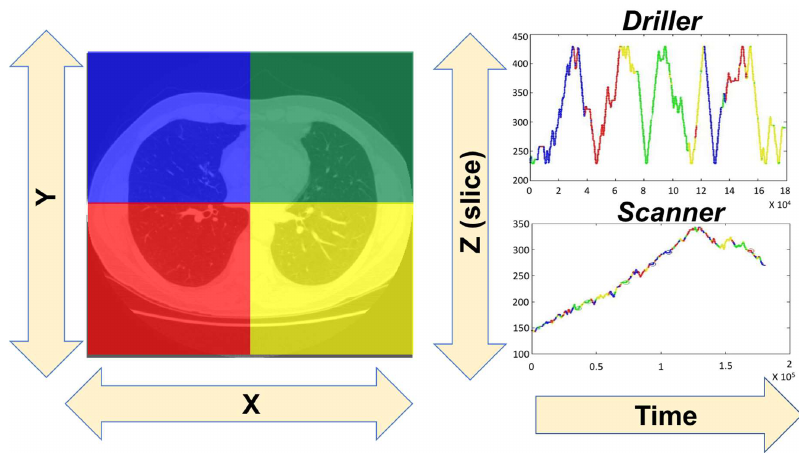
Figure 2. To visualize an approximation of the 3D scanpath through the lungs, position in the XY plane is coarsely color-coded into four quadrants (left-hand image). Depth (the slice in the stack) is plotted as a function of time-on-task on the right, with colors indicating the XY position. The terms “driller” and “scanner” are explained in the main